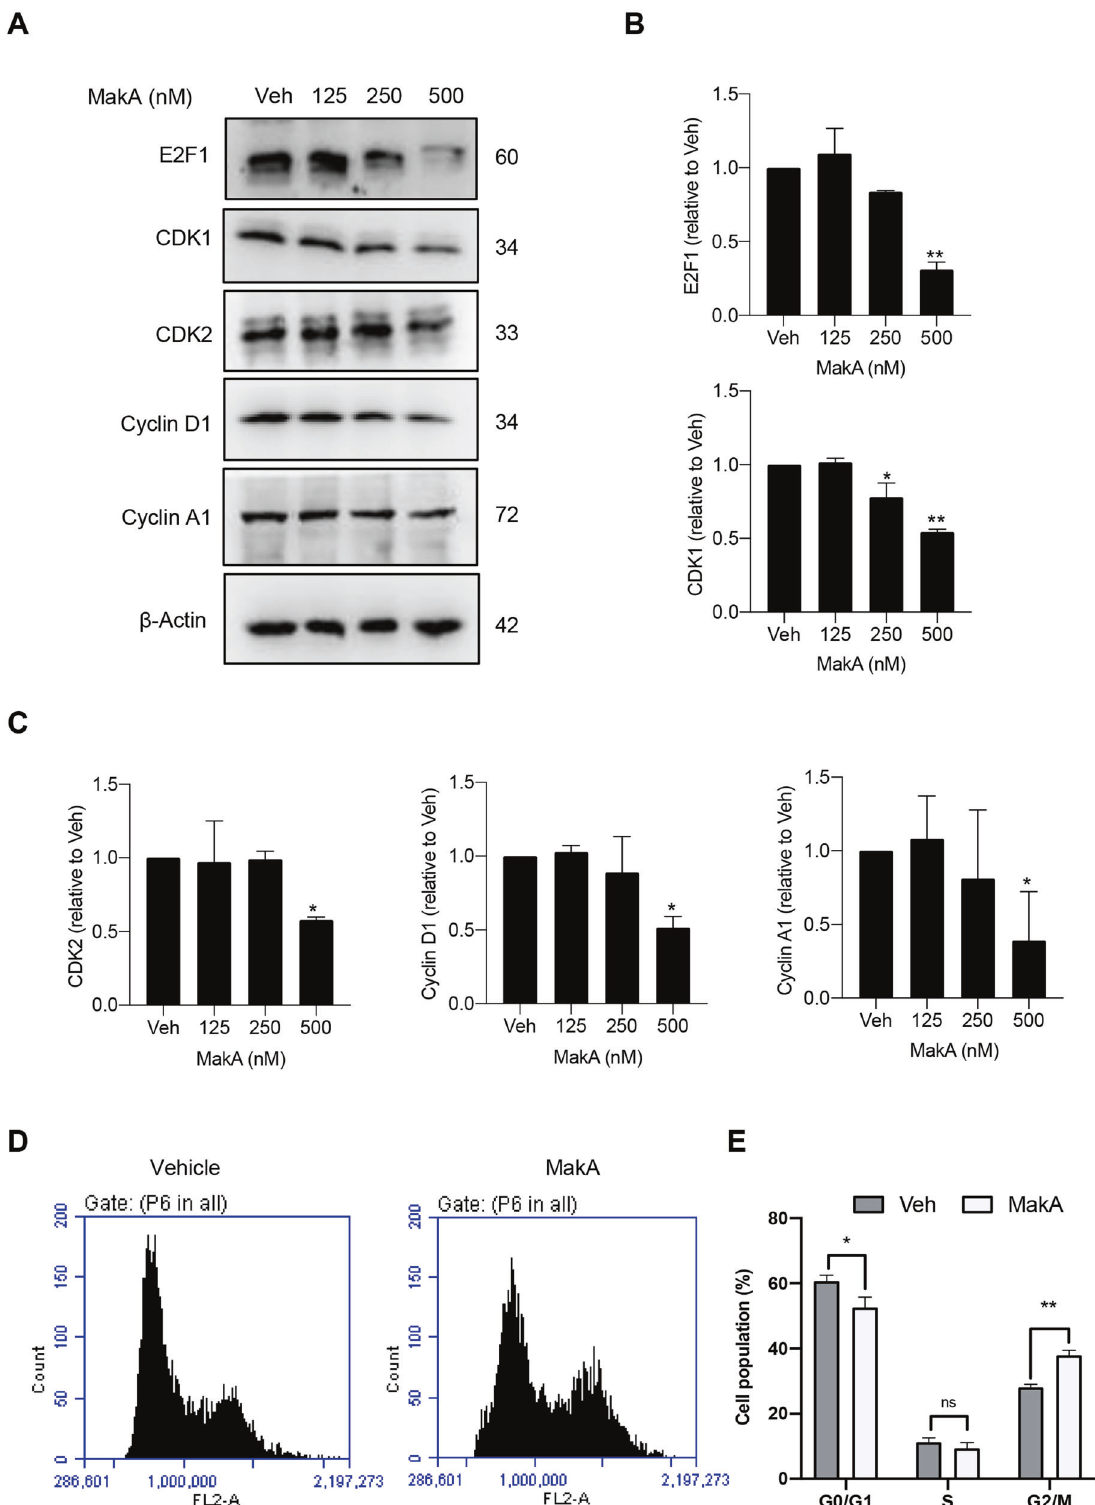
Fig. 4 MakA induces G2/M cell cycle arrest in HCT8 cells and alters the expression of cell cycle regulatory proteins. A Western blot analysis shows levels of E2F1, CDK1, CDK2, cyclin D1, and cyclin A in HCT8 cells treated with increasing concentrations of MakA (24 h). B , C Histograms indicate the normalized quanti fi cation of E2F1, CDK1, CDK2, cyclin D1, and cyclin A1 relative to total actin. Data is representative of at least two independent experiments and is expressed compared to cells treated with vehicle (20 mM Tris-HCl); bar graphs show mean ± s.d. Signi fi cance was determined using a one-way analysis of variance (ANOVA) followed by Dunnett ’ s post-test in comparison to the vehicle control * p ≤ 0.05 and ** p ≤ 0.01. D Cell cycle distribution fl ow cytometric analysis of HCT8 cells treated with MakA protein (500 nM, 24 h). E Histogram showing the distribution of HCT8 cells during each phase of the cell cycle after treatment with vehicle or MakA. Data are representative of three independent experiments. * p ≤ 0.05 and ** p ≤ 0.01. Cell Death and Disease (2022)